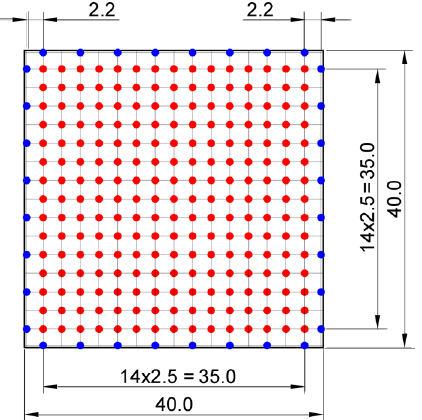
Fig. 9. Geometry of the slab and the arrangement of